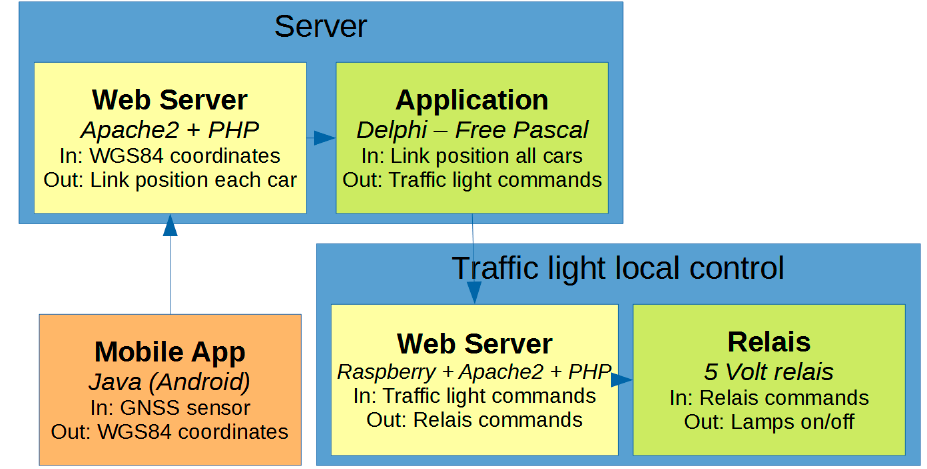
Figure 8. Data flow and general structure of the different software modules in the proposed system.